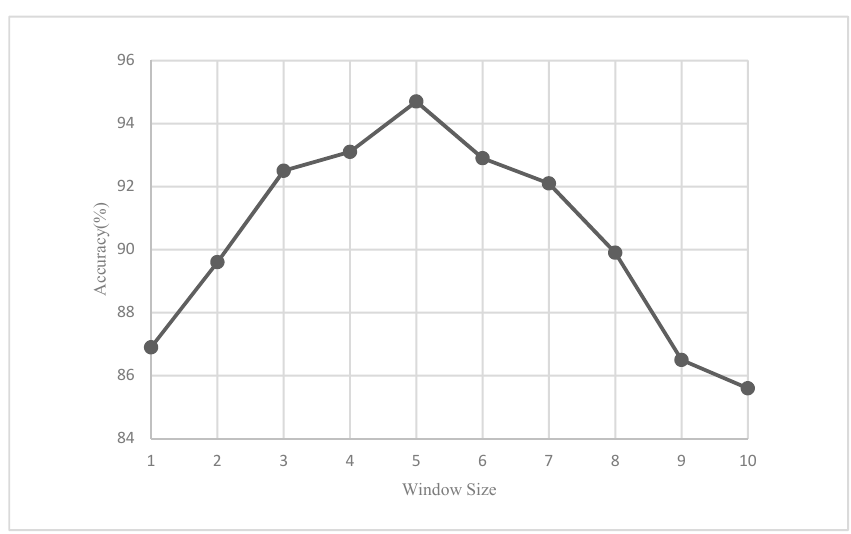
Figure 14. Comparison of recognition rate under different sliding windows.